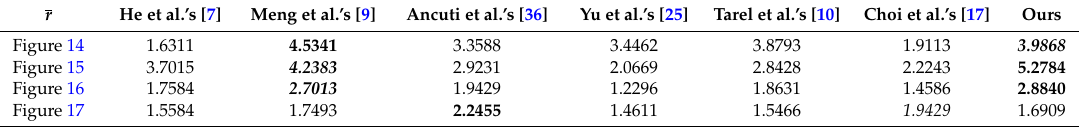
Table 2. Comparison of r for the dehazing results obtained via different methods.